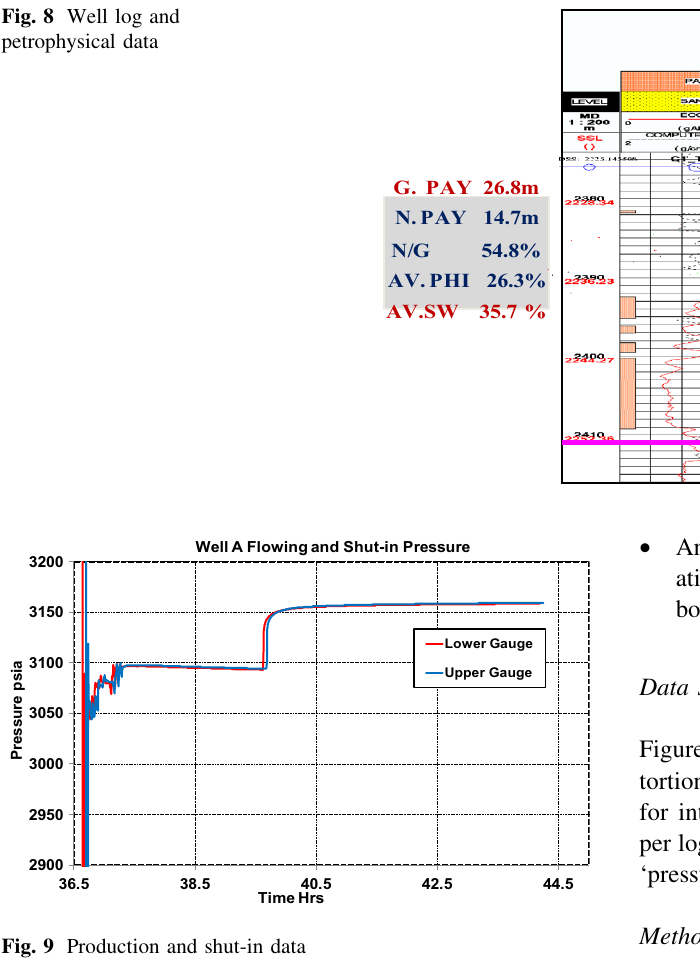
Fig. 9 Production and shut-in data